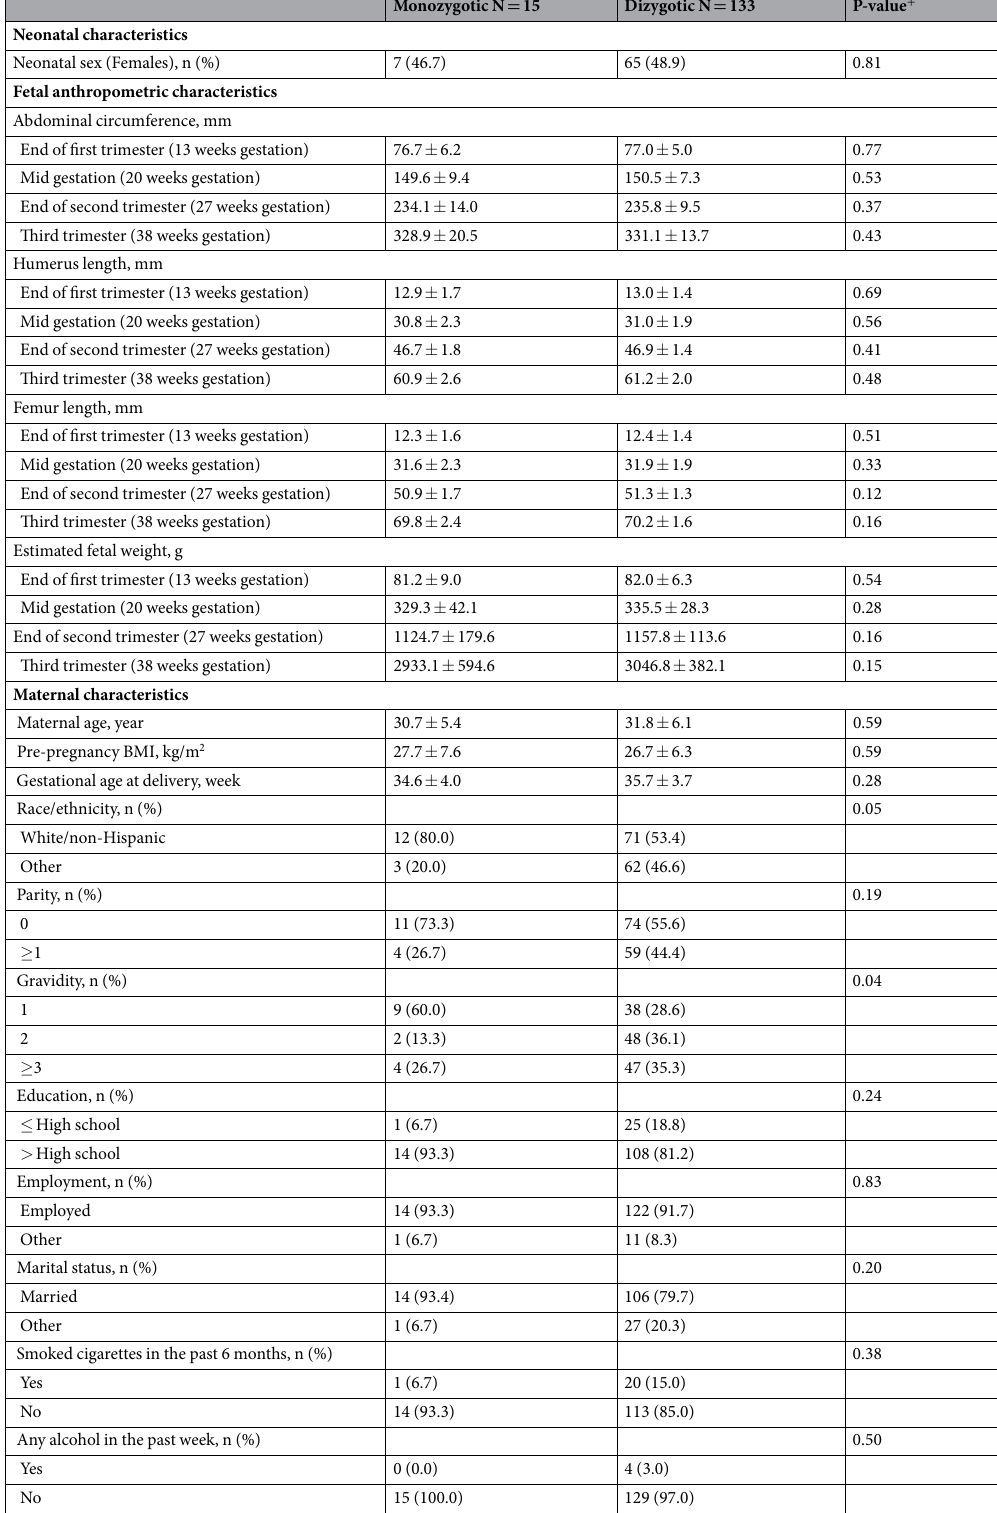
Table 1. Study characteristics of participants. + P-values were based on χ 2 test for categorical variables and t-test for continuous